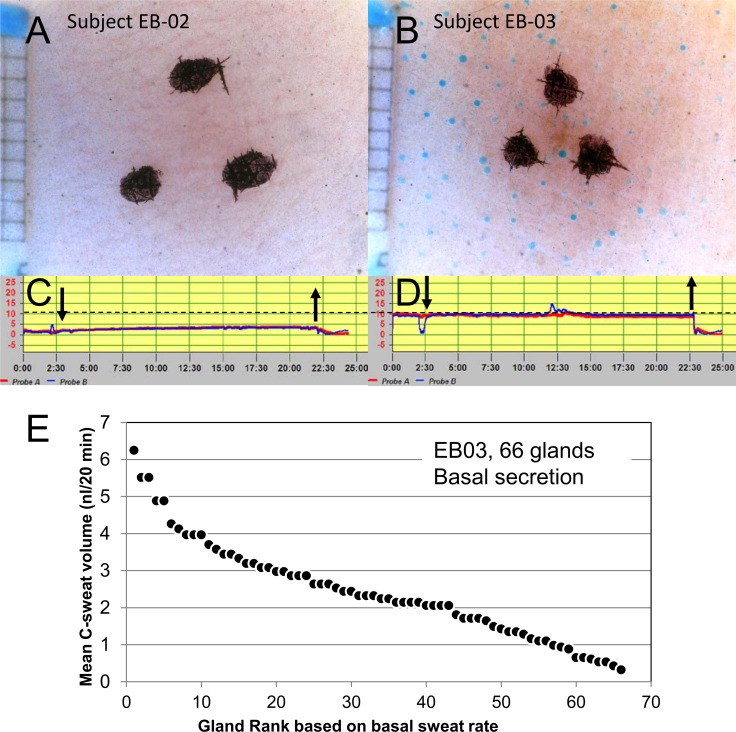
Bubble imaging and TEWL measures with evaporimetry in two subjects (EB-02, 03) who were not stimulated.(A-B) show sweat bubble imaging after 20 min with no applied stimulus (and with no atropine to block any baseline cholinergic secretion). (C-D) show evaporimetry traces at the same sites. The dashed line shows a stable and consistent difference between the two subjects of ~6 g/(m2·hr) or 10 nl/(cm2·min). The summed bubble secretion corrected for the 0.6 cm2 size of the imaged area was 13.4 nl/cm2 ·min. This agreement is at least as good as the agreement for bubble tests at same sites on different days shown in Fig 5. However, in subsequent tests with this subject no bubbles were observed in spite of the same TEWL (see text). (E) Distribution of single gland basal secretion rates for sweat bubbles (n = 66) shown in panel (B). Each point plots the volume (y-axis) and rank for an individual gland.